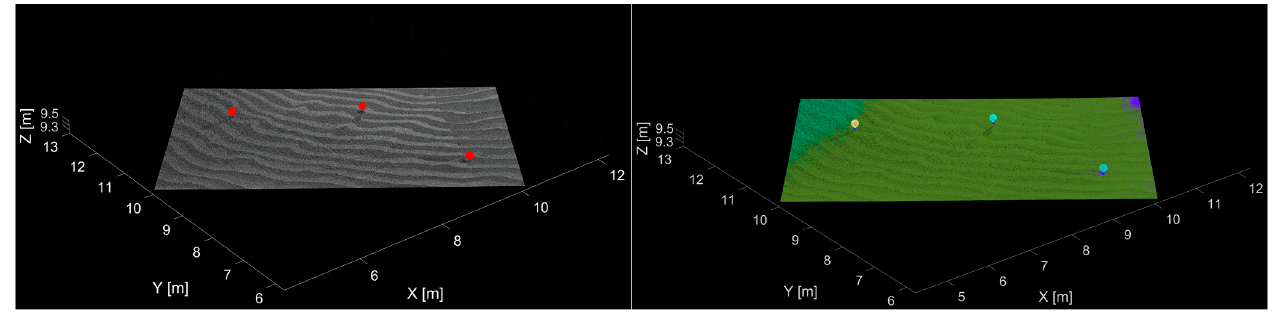
Figure 16. Comparison of the result of the sphere segmentation from the proposed algorithm ( left ) and the standard RANSAC algorithm ( right ).